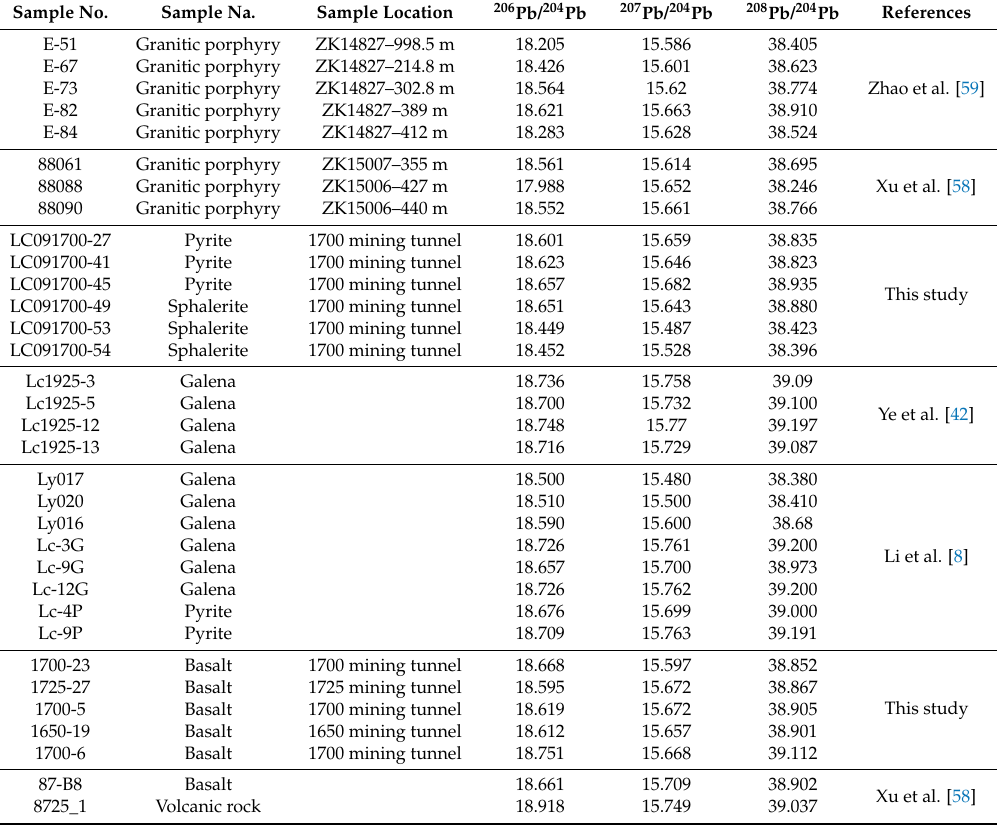
Table 4. Pb isotope data of rock and sulfides from the Laochang